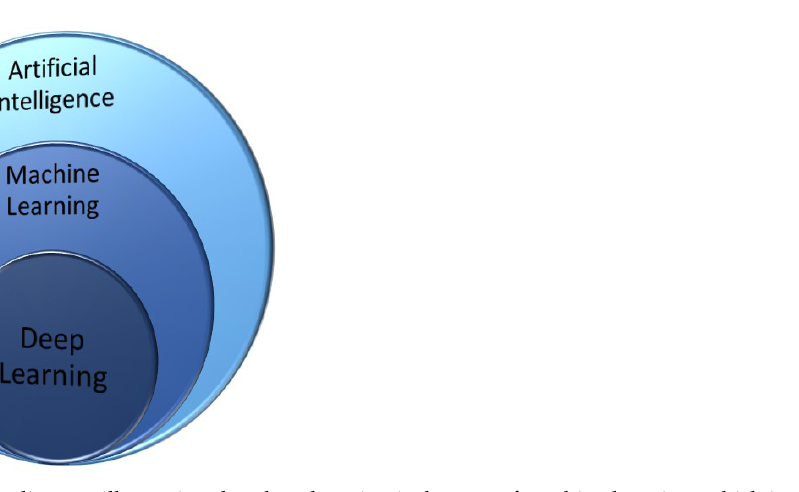
Figure 14. Venn diagram illustrating that deep learning is the core of machine learning, which in turn is a technique within AI methods.